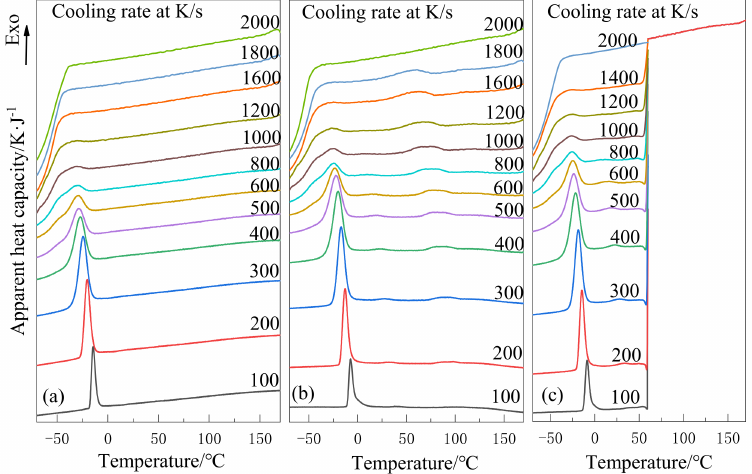
Figure 2. Non-isothermal crystallization curves at different cooling rates: ( a ) poly(ethylene glycol) (PEG) in method 1, ( b ) poly(ethylene glycol)–poly( L -lactide) diblock copolymer(PEG-PLLA) in method 1 and ( c ) PEG-PLLA in method